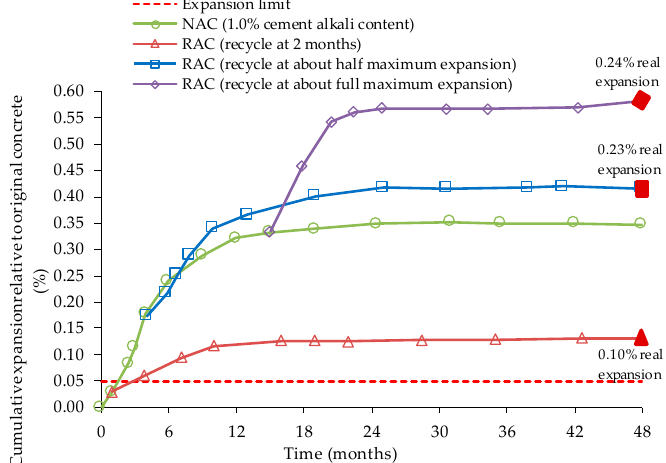
Figure 5. Expansion of high alkali mixes with coarse RA, from high alkali OC, and high alkali cement in ASTM C 227, adapted from [74].